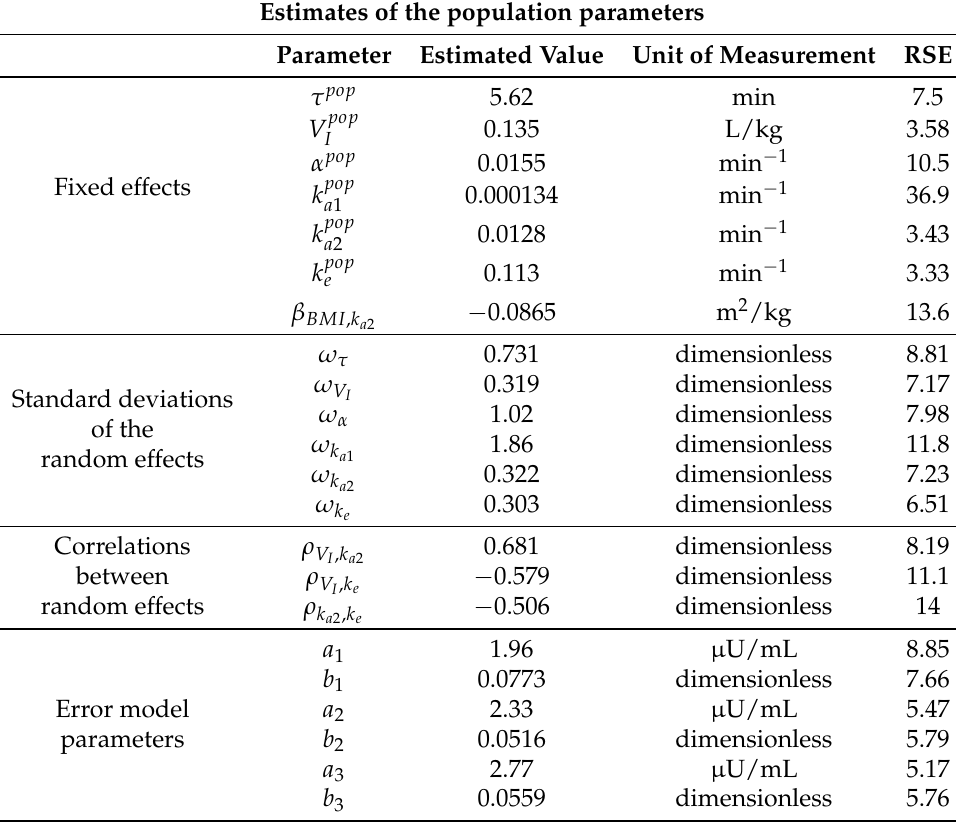
Figure 6. Visual predictive check obtained with the selected variability model (Model 11). The 90% prediction intervals of the 10th (blue lower area), 50th (red central area), and 90th (blue upper area) percentiles are compared with the 10th, 50th, and 90th empirical percentiles (black solid lines). Outliers are marked with red circles. Table 2. Estimated population parameters of the model and their corresponding